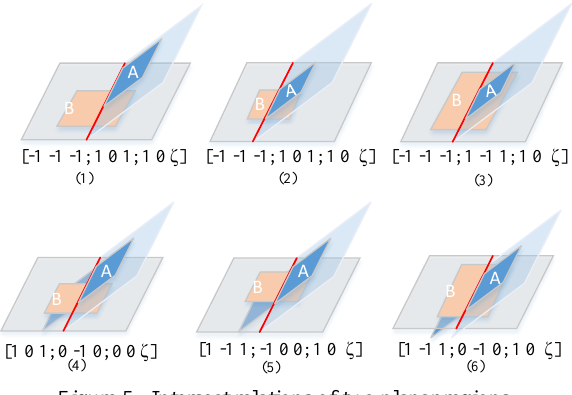
Figure 5. Intersect relations of two planar